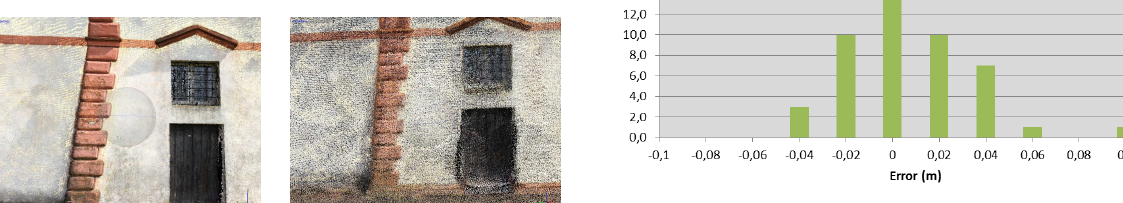
Figure 23. Frequency histogram of the height deviations of natural control points positions.